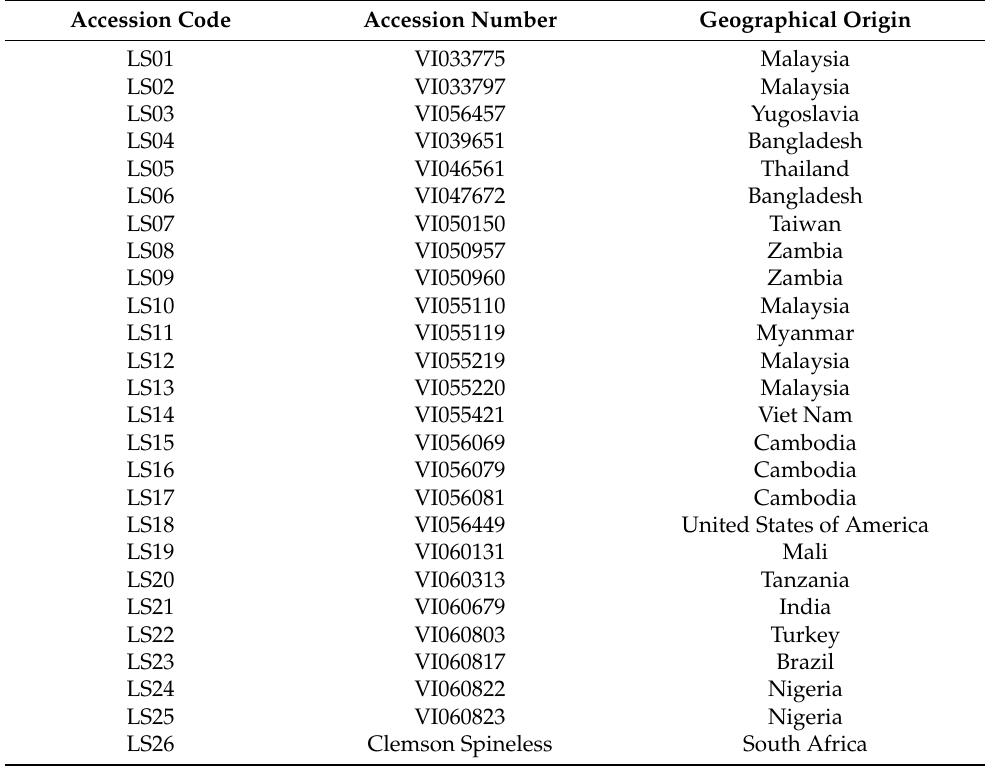
Table 1. Accession code and number, and geographical origin of the okra accessions used in the